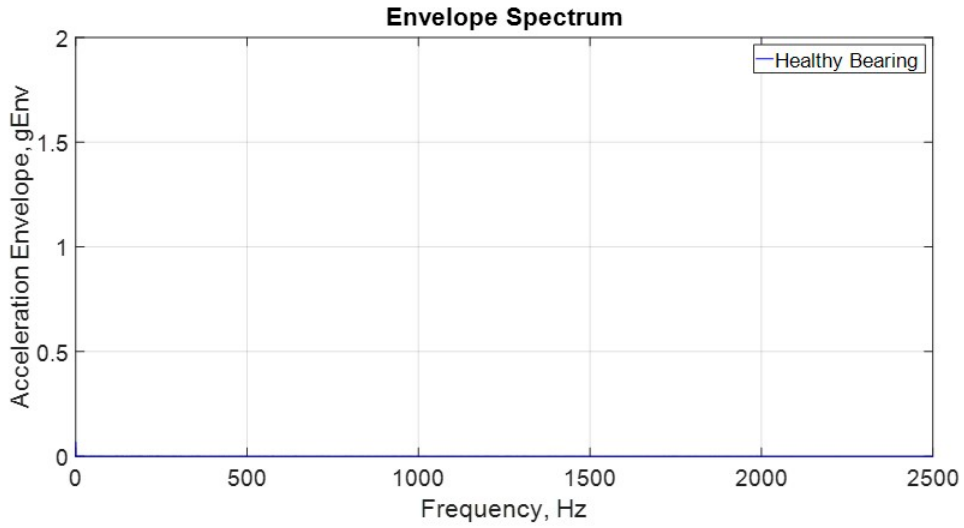
Figure 5. Acceleration envelope spectrum for the healthy bearing.